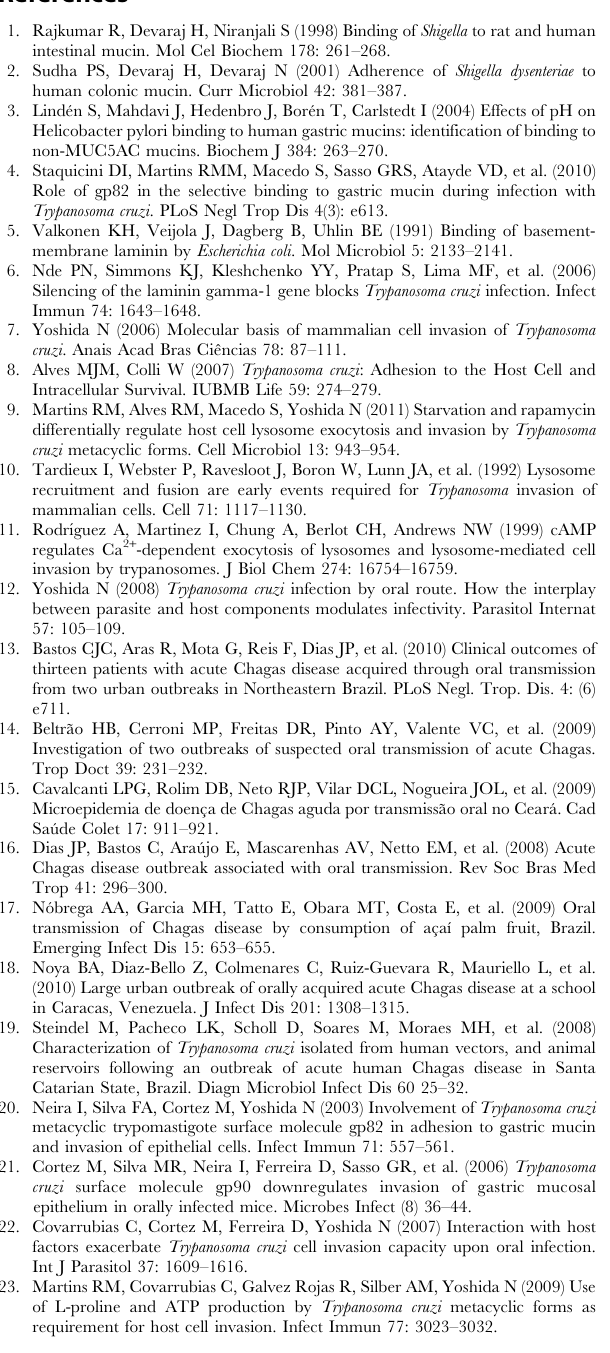
Figure S3 The MT gp82 VTV motif. A) VTV motifs of gp82 and Tc85-11 are aligned. B) Surface representation of gp82 VTV motif.